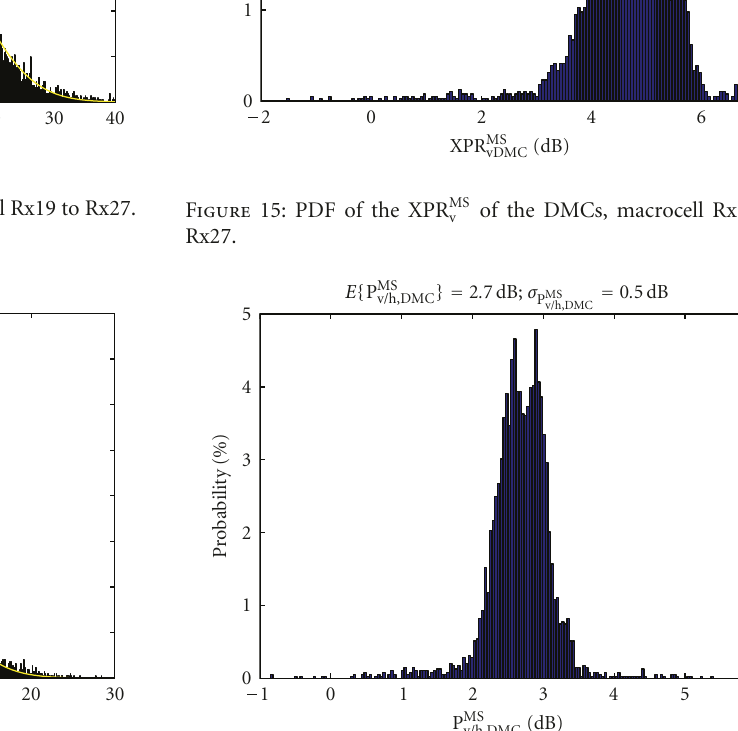
of the DMCs, macrocell Rx19 to v/h